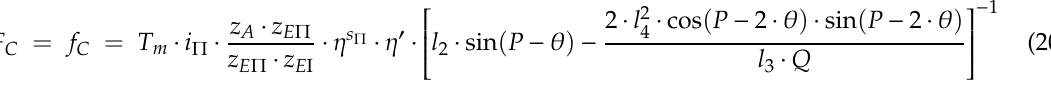
Figure 9. Fitting curve of test values F TC compared with the theoretical values F C of the expanding force feature.